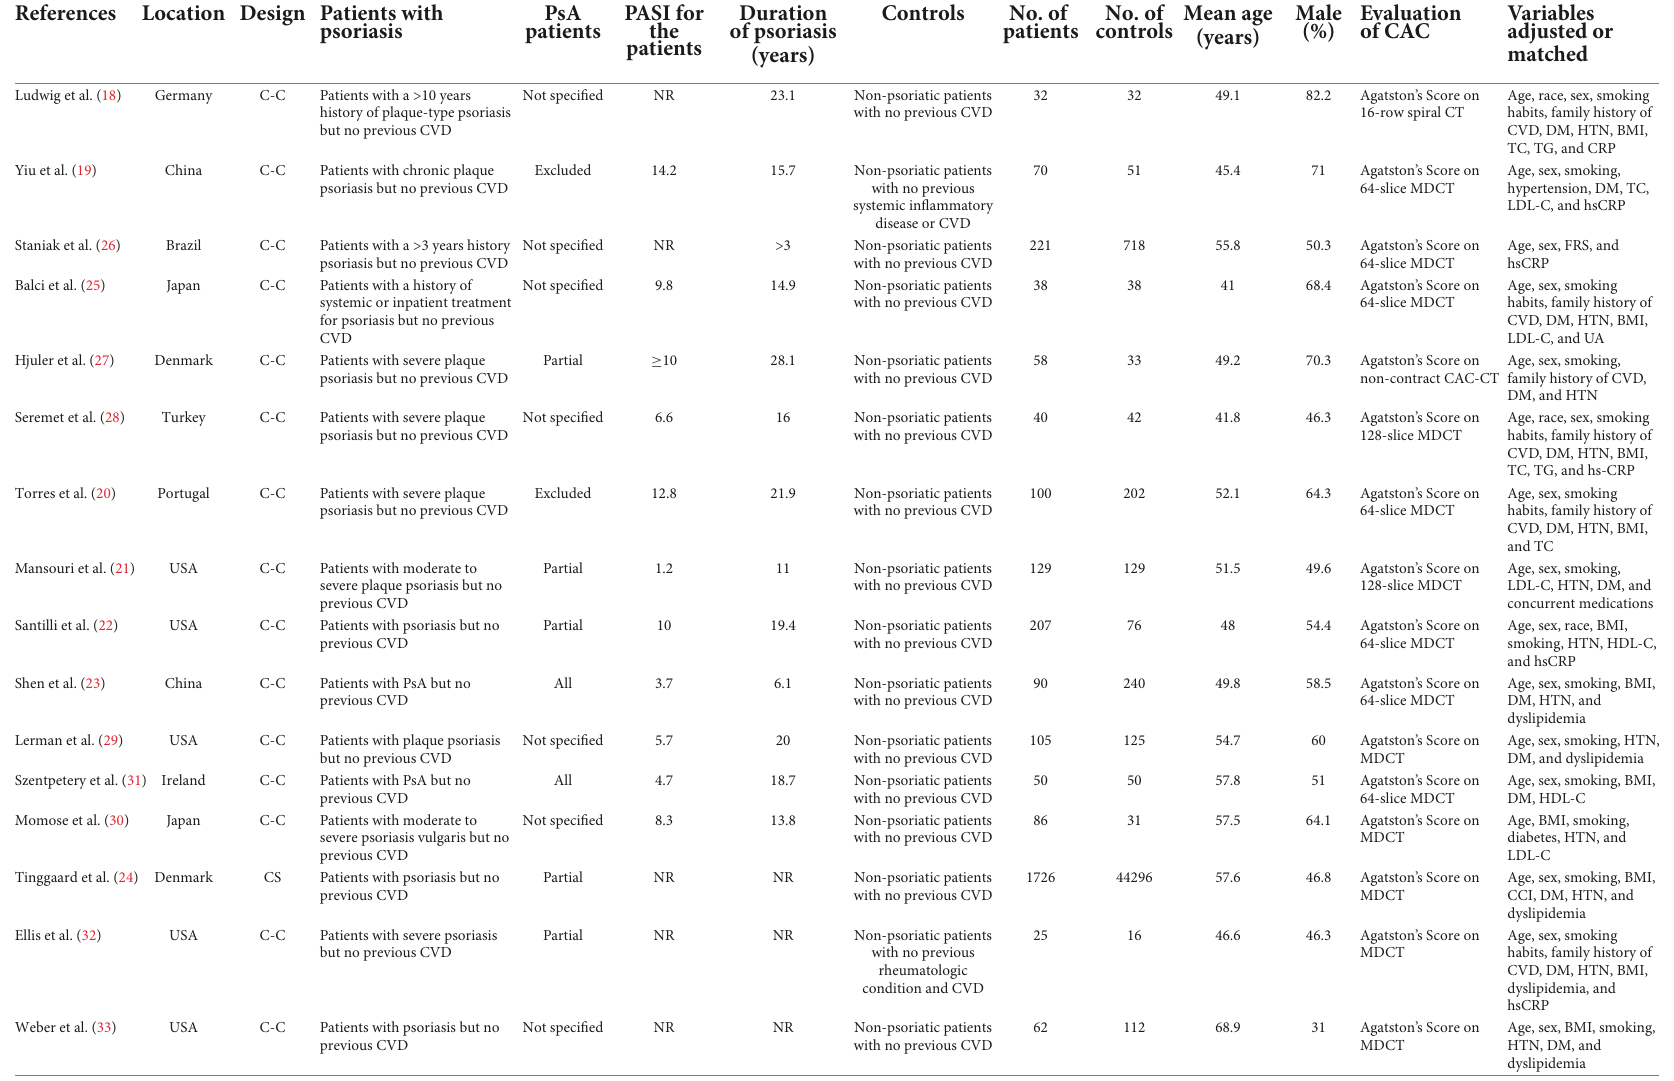
TABLE 1 Characteristics of the included